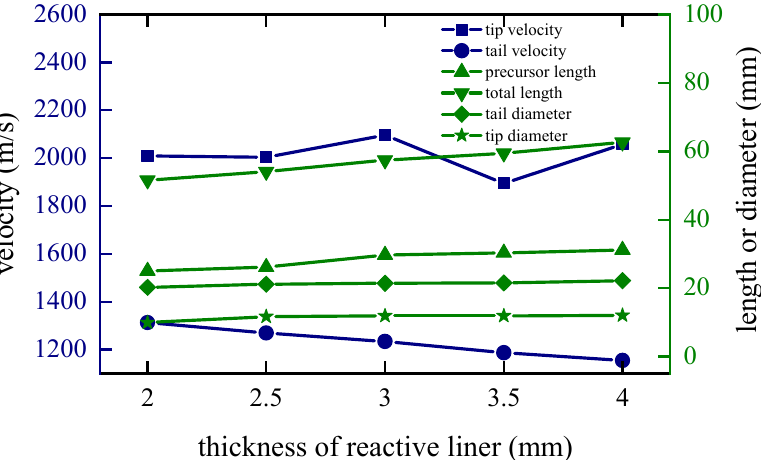
Figure 15. Curves of coating EFP shape parameter change.